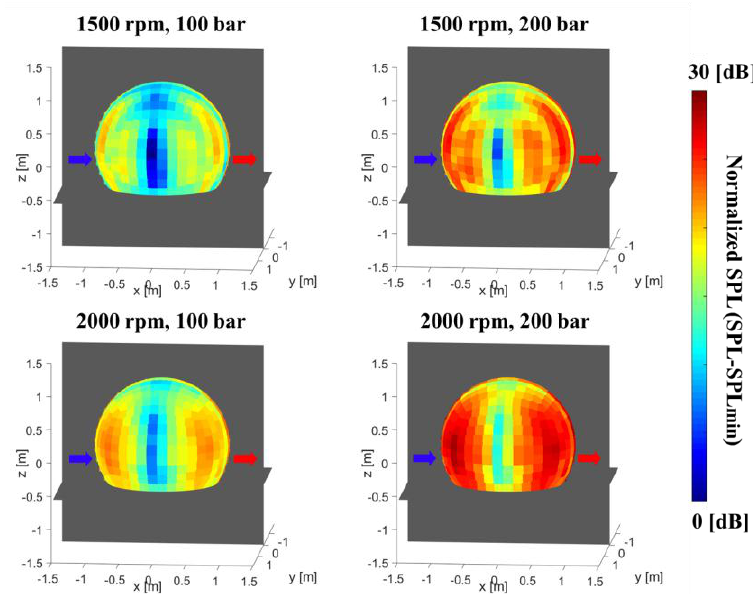
Figure 21. Normalized SPL distribution for the four different operating conditions.